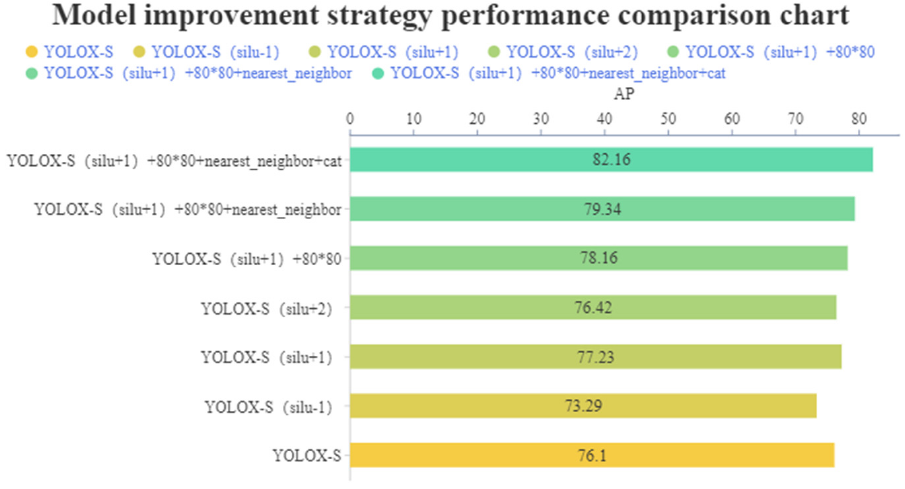
Figure 10. Model improvement strategy performance comparison chart.